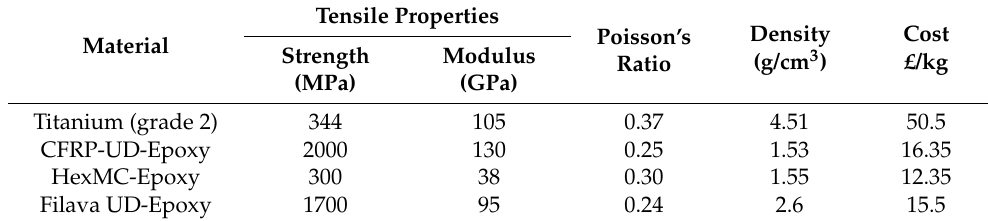
Table 1. Mechanical properties of the potential materials [5]